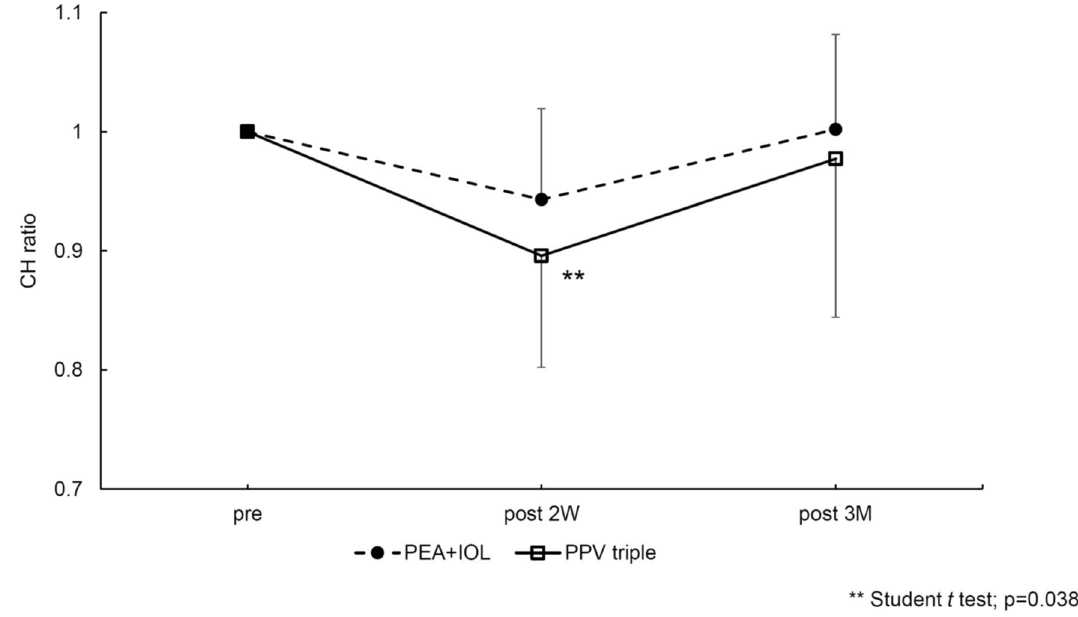
Figure 1. The postoperative to preoperative CH ratio of the PEA + IOL group was 0.94 ± 0.08, 1.00 ± 0.08, and for the PPV triple groups was 0.89 ± 0.09, 0.98 ± 0.13, 2 weeks, and 3 months postoperatively, respectively. The CH ratio was significantly smaller in the PPV triple group compared to the PEA + IOL group at 2 weeks postoperatively (**p < 0.05).